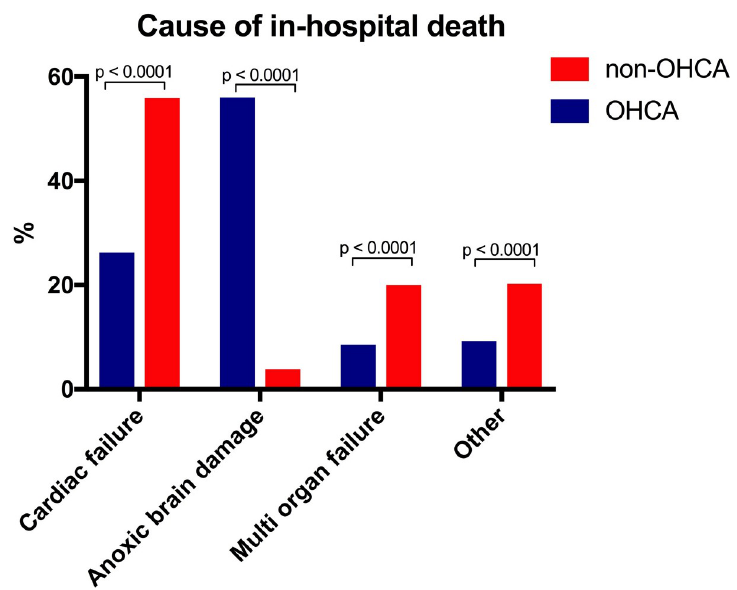
Fig 3. Bar chart depicting cause of in-hospital death among the complete cohort (n = 1716) stratified into subgroups presenting with and without out-of-hospital cardiac arrest. OHCA: Out-of-hospital cardiac arrest.